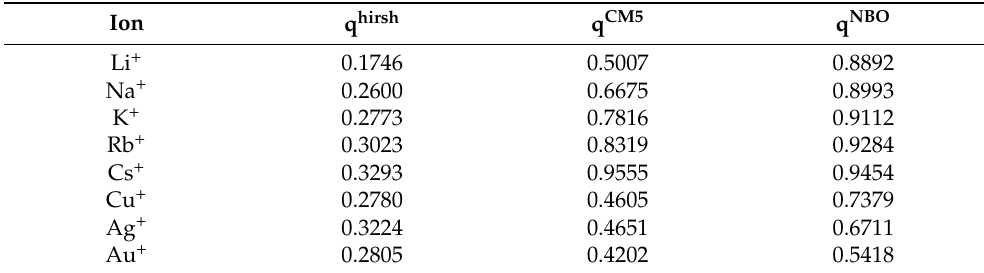
Table 4. Atom charges after the charge transfer (CT) from ligands to the metal cation in salinomycin complexes with two water molecules from Hirshfeld, CM5 and NBO population analyses (in e). Ion q hirsh q CM5 q NBO Li + 0.1725 0.5074 0.9005 Na +